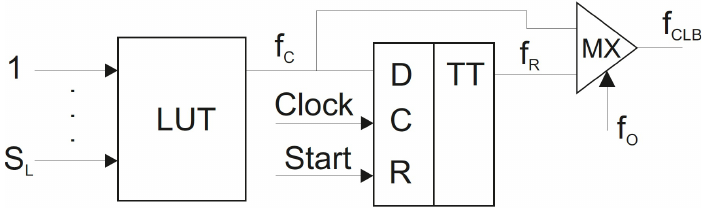
Figure 1. Architecture of a look-up table (LUT)-based configurable logic block